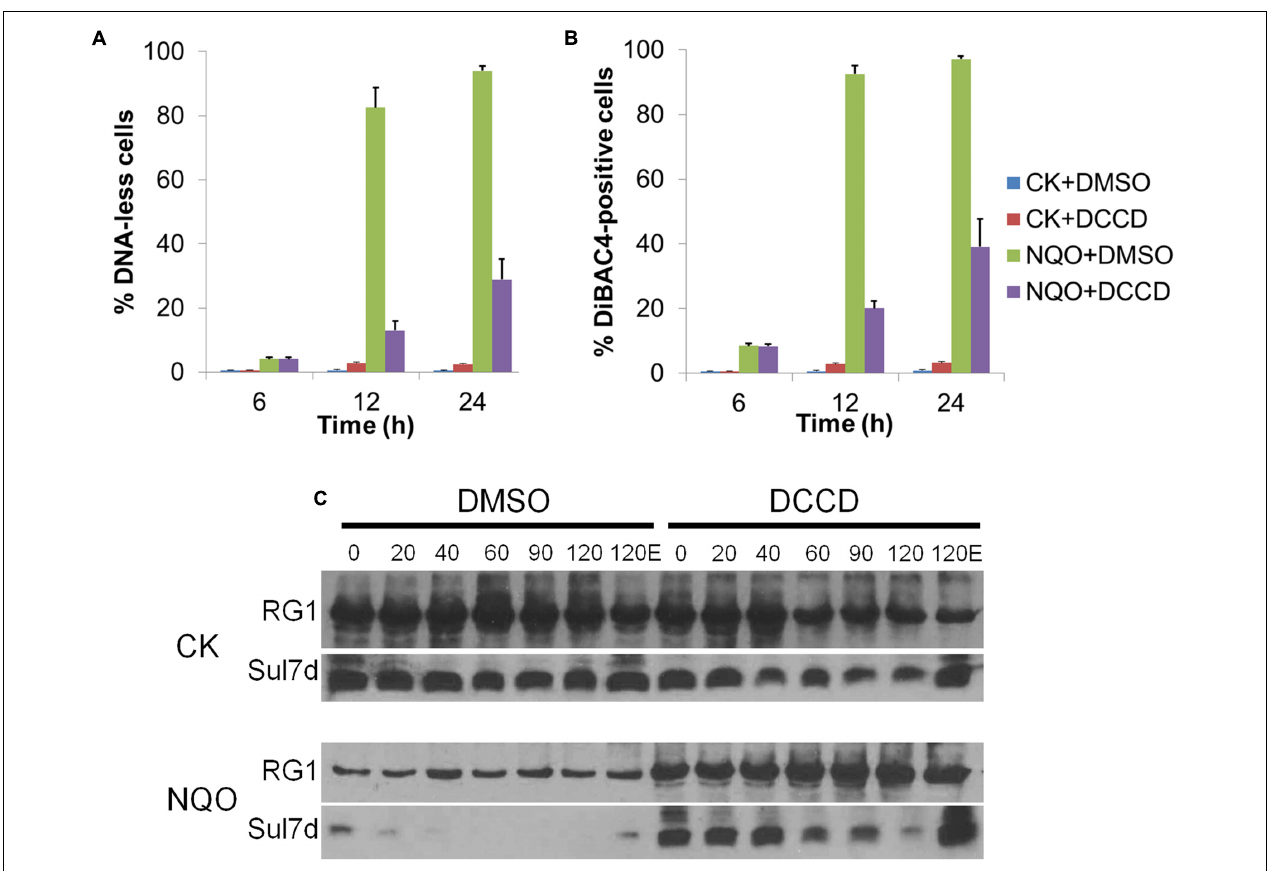
FIGURE 6 | Dicyclohexylcarbodiimide (DCCD) inhibits the NQO-induced DNA-less cell formation and proteolytic degradation of chromatin protein. (A,B) The cultures after 6 h NQO treatment or no treatment were supplemented with DMSO or DCCD, respectively. Then, at 12 and 24 h after NQO supplementation, the percentage of DNA-less cells (A) and DiBAC-positive cells (B) was analyzed by flow cytometry. Error bars represent SD of three independent experiments. (C) Cell extracts were prepared at 12 h during the treatments as described in (A,B) . Then, the degradation of Sul7 was analyzed by the in vitro proteolytic assay as described in Figure 3B . The cell extracts were incubated at 75 ◦ C for 120 min, during which levels of Sul7 from 20 µ g of total protein was monitored by western blot. “120E” represents the sample supplemented with EDTA and incubated for 120